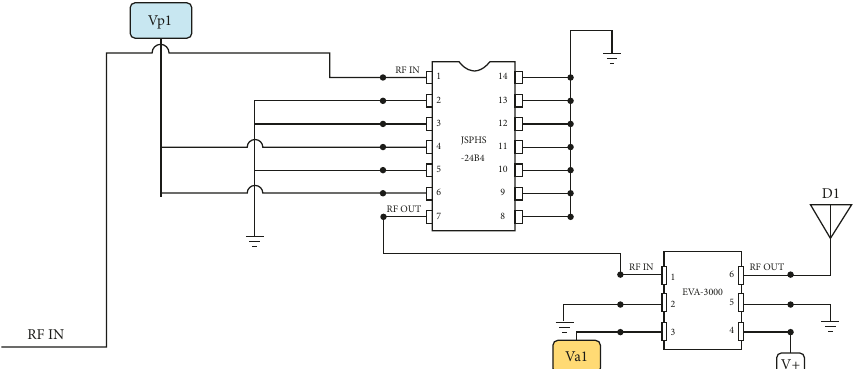
Figure 10: A schematic diagram of a single way SMD phase shifter and attenuator.